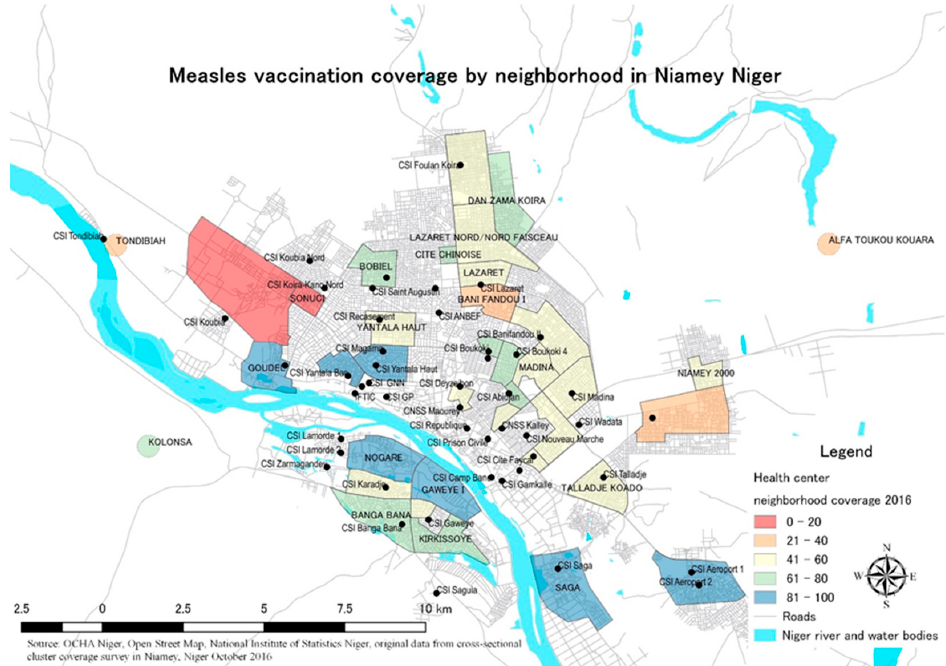
Figure 1. Measles 1 vaccination coverage (%) by neighborhood in Niamey, Niger. Source: base maps from OCHA Niger, Open Street Map, and National Institute of Statistics Niger. Measles 1 vaccination coverage data from Kondo Kunieda et al. (2021).